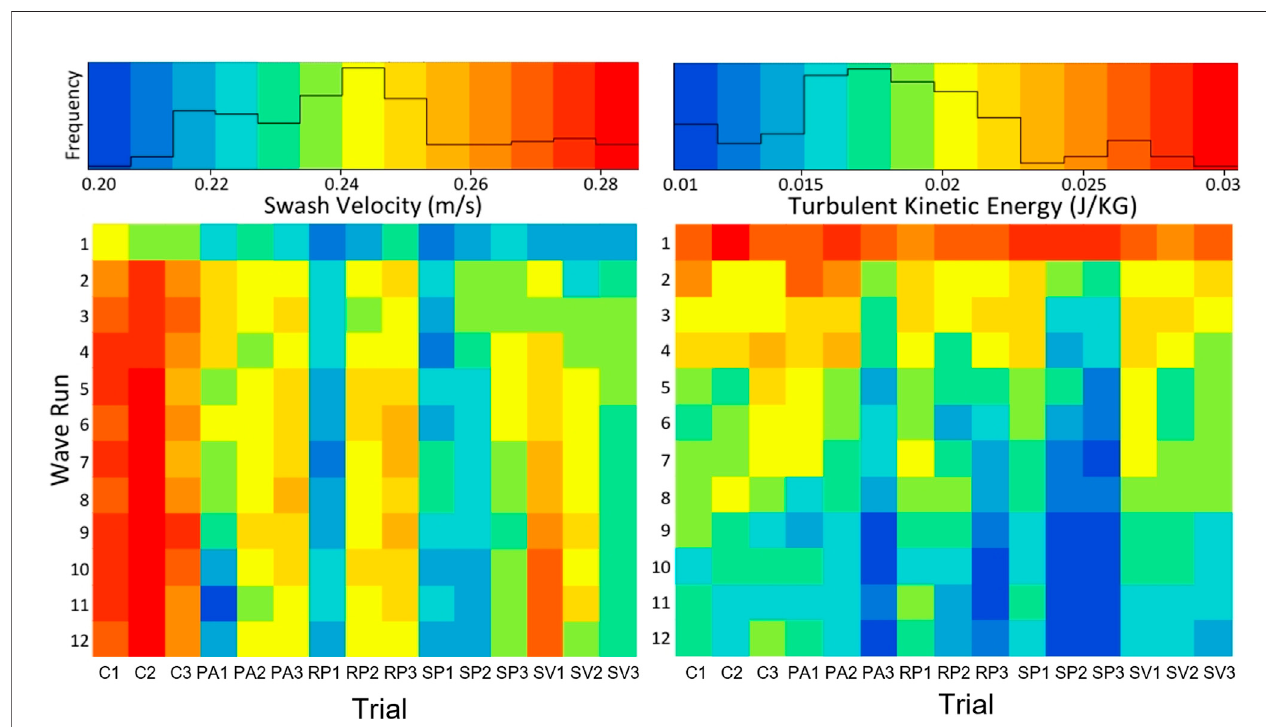
FIGURE 4 | ADV-measured cross-shore swash velocity component u (left panels) and computed TKE (right panels) using Eq. 2 for each wave run and every experiment trial. The top row of panels includes the respective color key maps linking colors to speci fi c parameter value ranges. The bottom row of panels shows the actual dataas color matrices. Each column represents aseparate trial asindicated by thetrialID ( Table 1 ). Each row representsa single wave run (210 s) from top (1)to bottom (12). The frequency of occurrence of speci fi c value bins is indicated by the histograms overlaid on top of the respective color key maps.